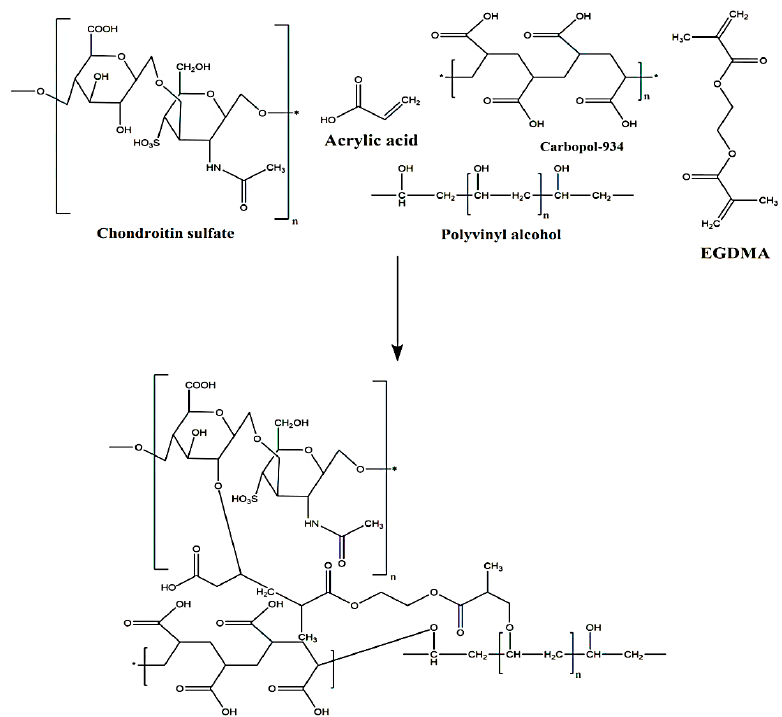
Figure 1. Proposed chemical structure of CS/CP/PVAcPAa hydrogel.